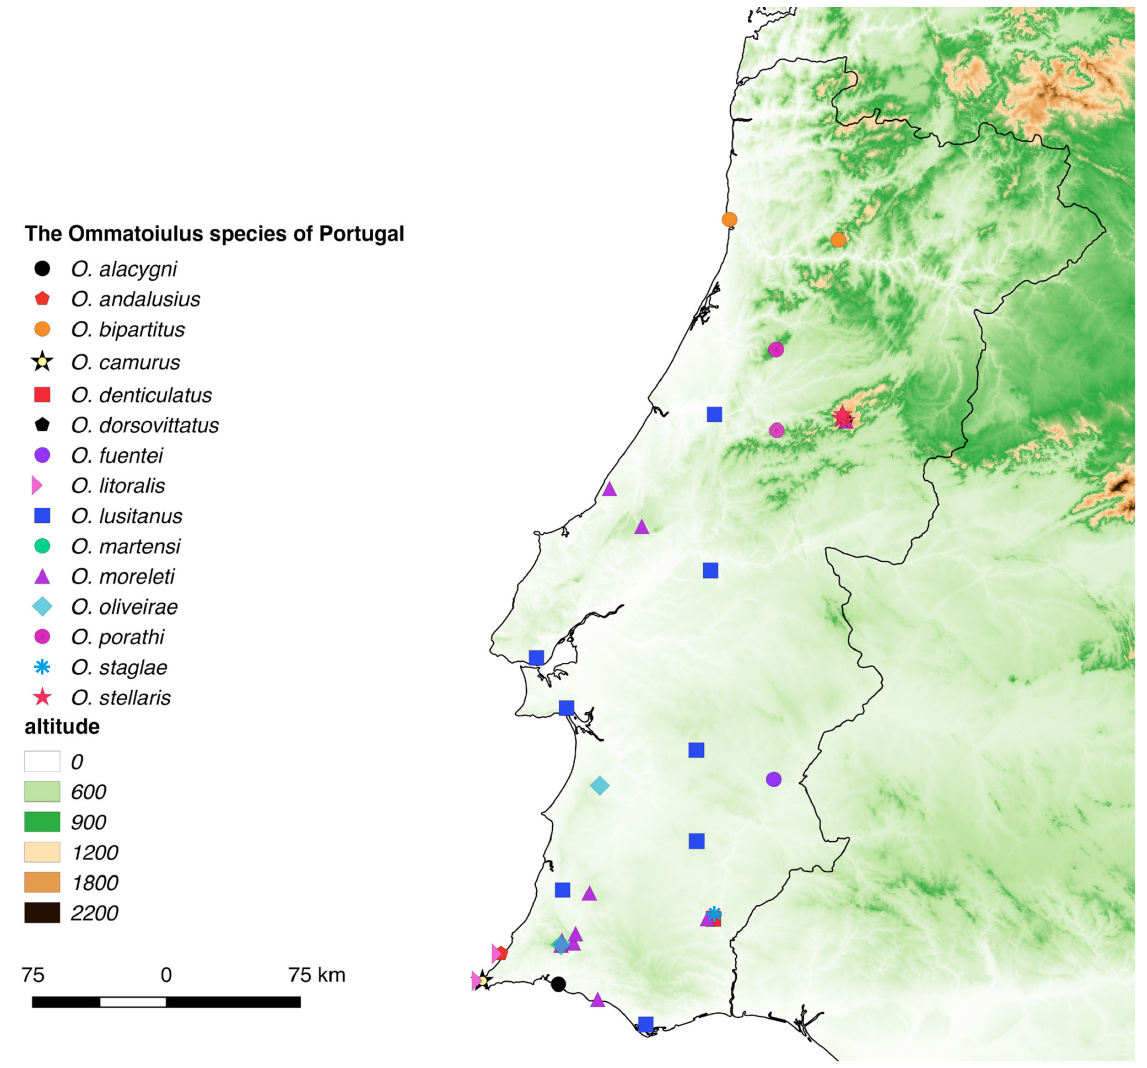
Fig. 26. Distribution map of Ommatoiulus species in